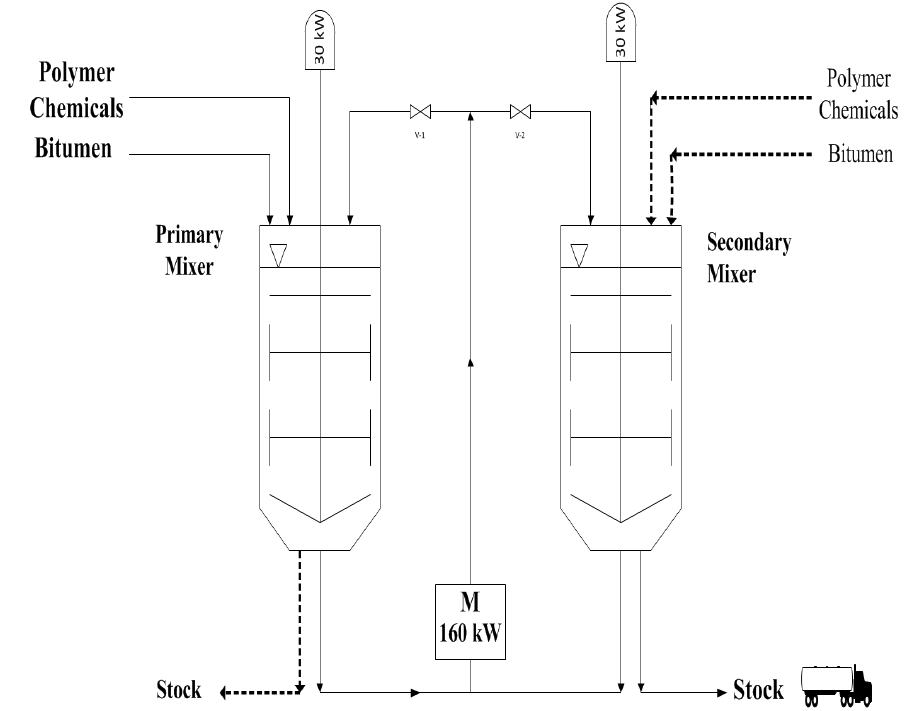
Figure 2. Batch production process of modified bitumen.